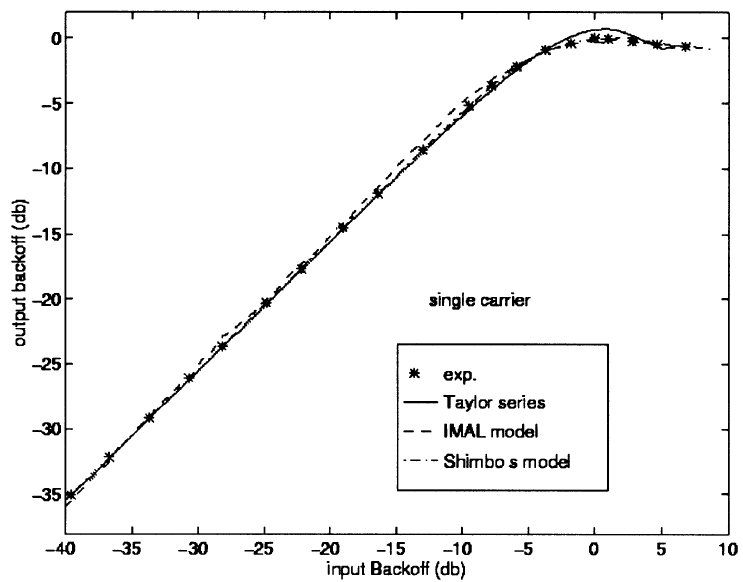
FIGURE 6 Correlation between experiment and theory for different number of